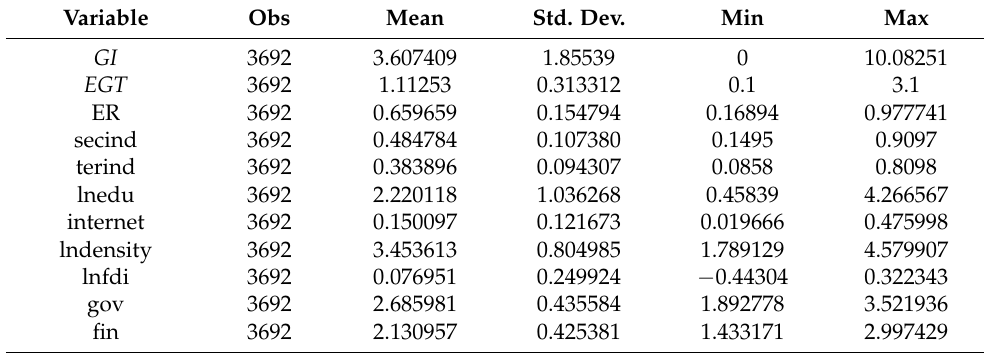
Table 1. Descriptive